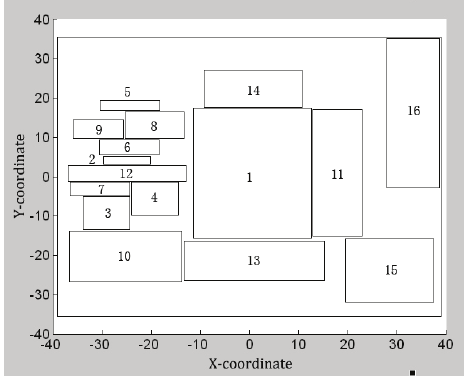
Fig.3. Special case of optimal layout